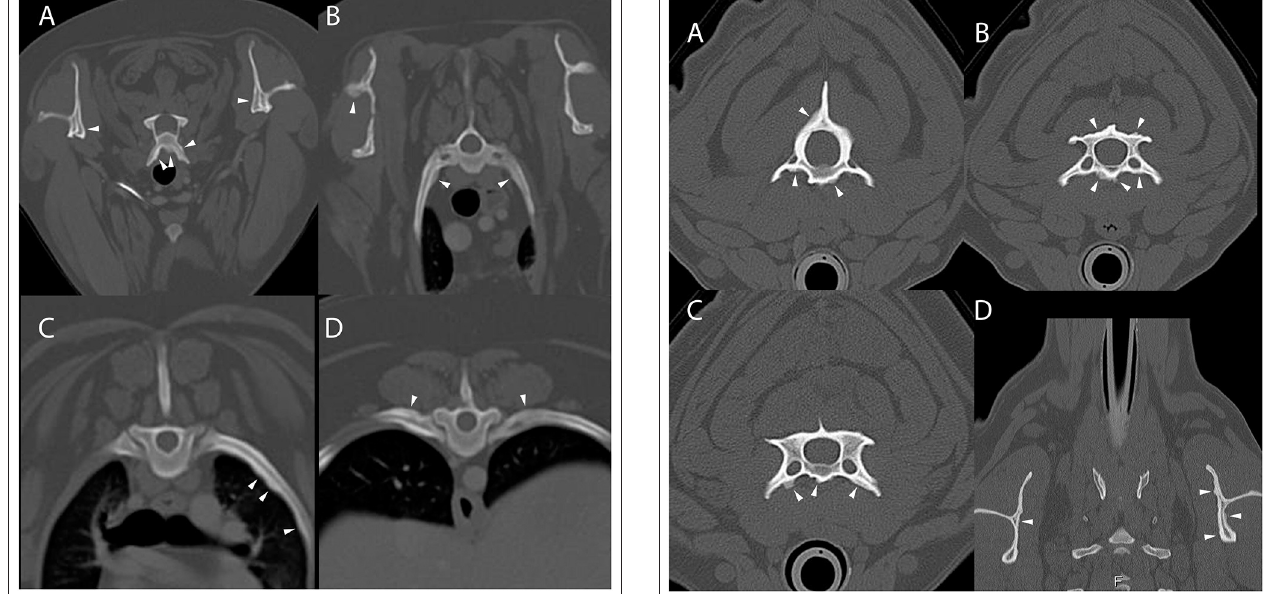
FIGURE 2 | Example of suspected lesions of American canine hepatozoonosis. Non-contrast transverse images of the second (A) , third (B) , and fourth cervical vertebrae (C) and a dorsal image at the level of the scapulae (D) in a 2 year-old male castrated Rhodesian ridgeback dog that tested positive for Hepatozoon americanum polymerase chain reaction. In all images, there is multifocal, irregularly marginated, periosteal proliferation on several non-articular surfaces of the vertebrae (white arrowheads). In (A) , the ventral vertebral body, transverse processes and dorsal arch are asymmetrically affected. In (B) , the lamina and ventral vertebral body have similar lesions that vary in thickness depending of the location. In (C) , the periosteal proliferation is restricted to the ventral surface of the vertebra. None of the lesions bridge the space between adjacent vertebrae. In (D) , the scapulae have mild asymmetric lesions on the medial aspect. The left scapula also has periosteal proliferation of the infraspinous